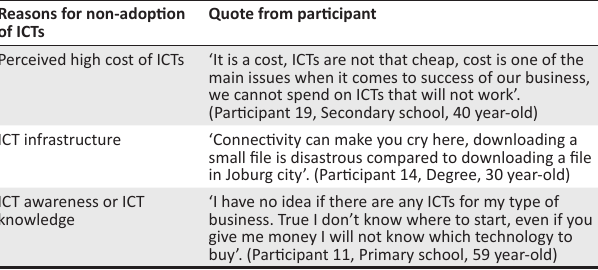
TABLE 7: Reasons for non-adoption of information and communication technologies. Reasons for non-adoption of